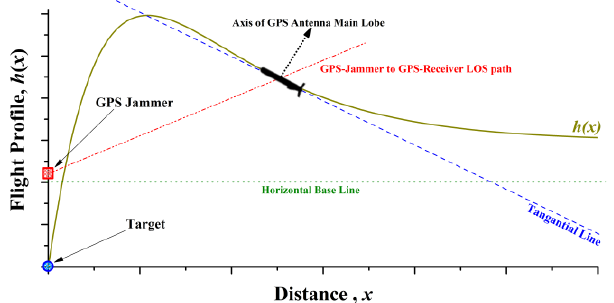
Figure 2. the figurative representation of simplified problem to calculate the normalized received power but the GPS receiver antenna onboard of missile